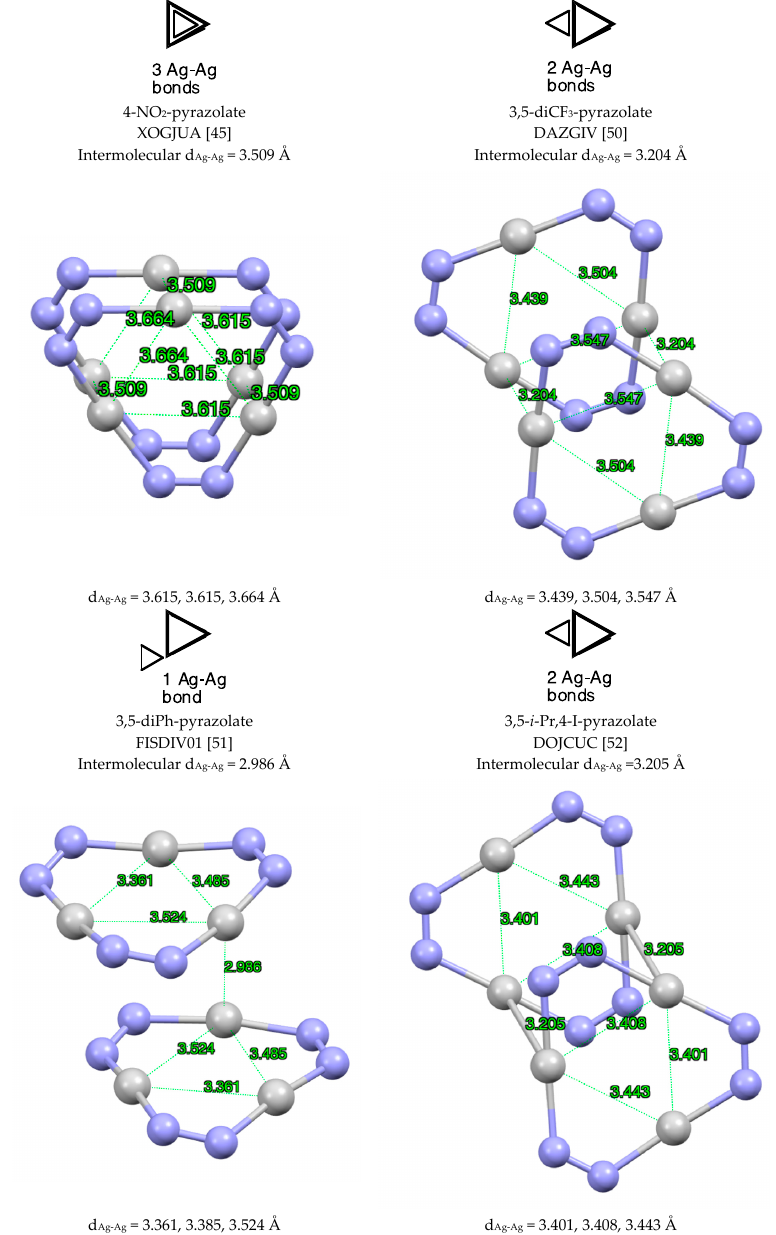
Figure 6. Differentmodesof“3 + 3”(pzAg) 3 complexes.